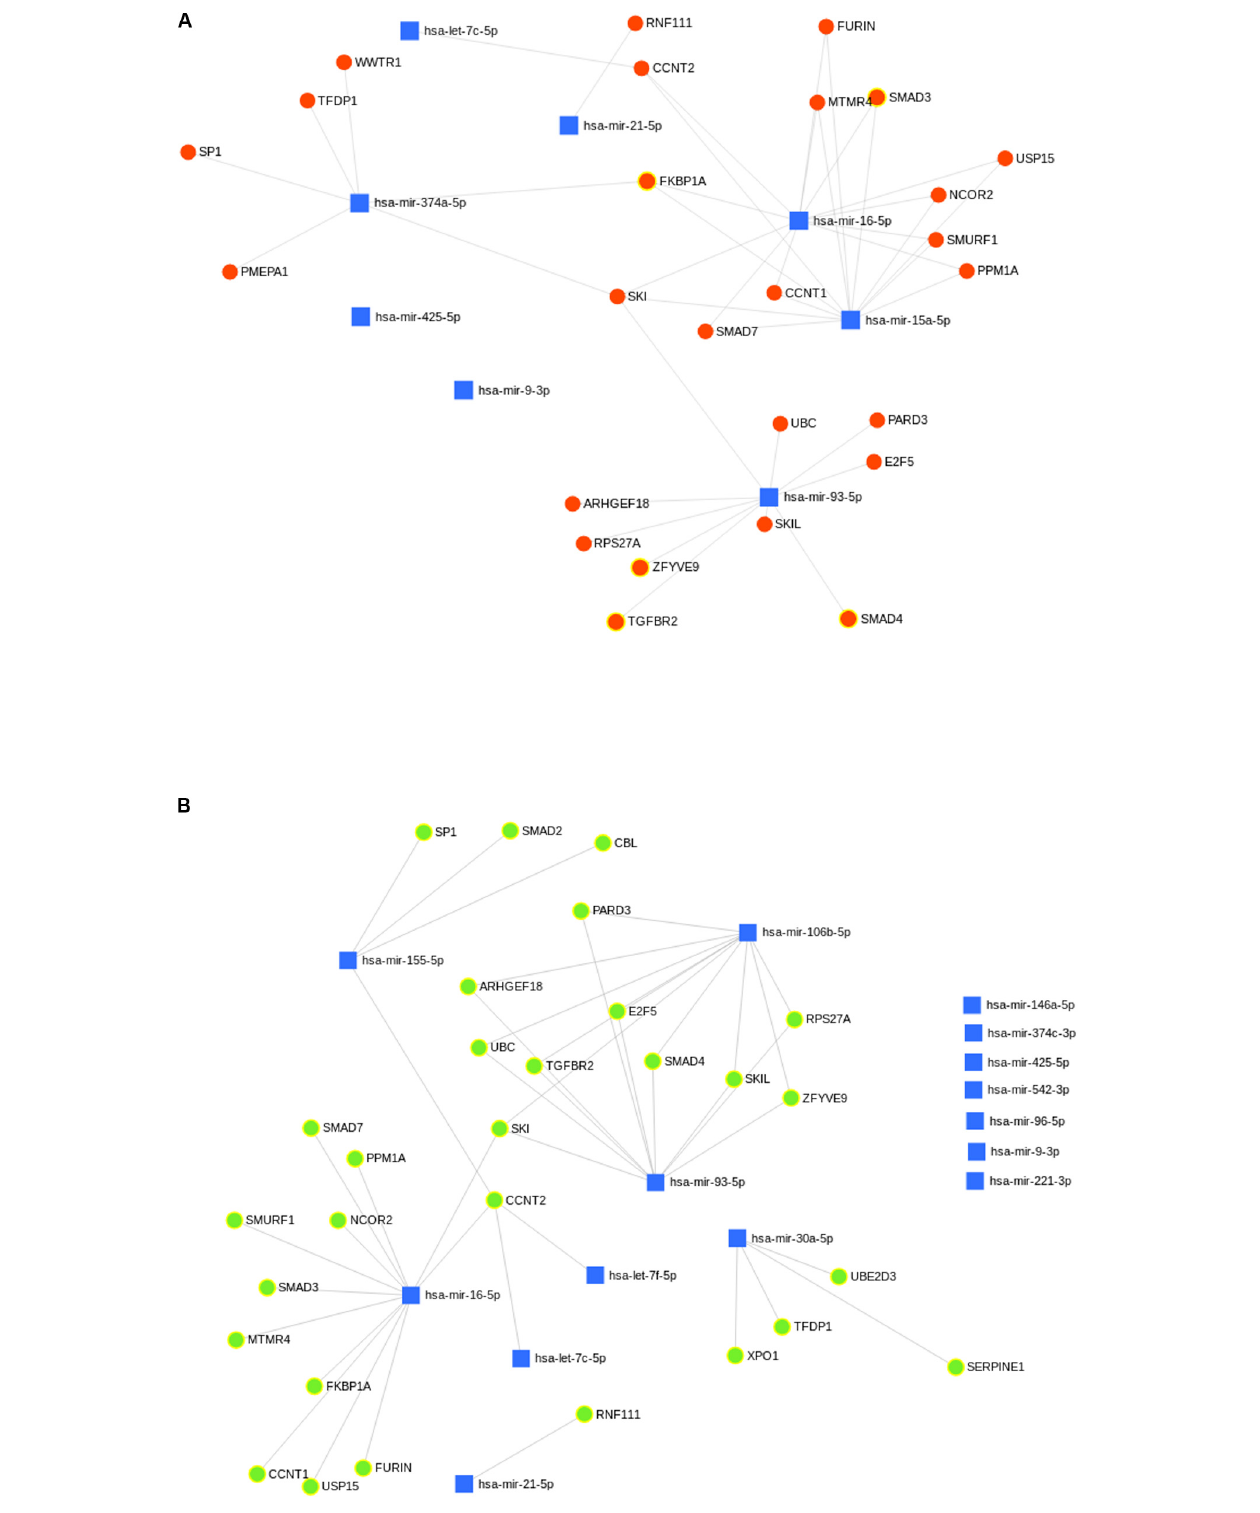
FIGURE 8 | (A,B) Predicted biological processes of upregulated microRNA (miRNA) in G PKDL with respect to (A) G THP and (B) G VL . The interlinked miRNAs and important pathways linked to macrophage effector functions. The interaction of upregulated miRNAs and their targeted biological processes. The highlighted red and green colors denote interlinked miRNAs with key biological processes relevant to macrophage dysfunction such as cytokine response, immune response, etc.